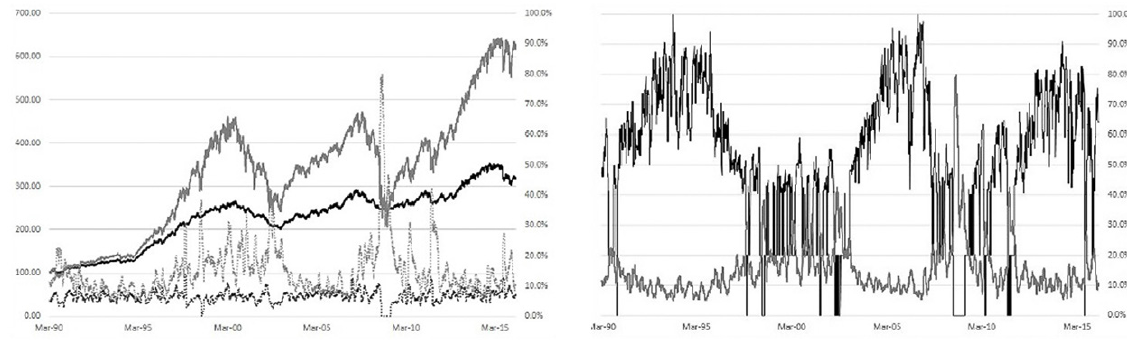
Figure 4. Comparative results for the DTVS VIX portfolio and the S&P 500 Note: The left side presents the path of DTVS VIX (solid black line) and of S&P 500 (solid gray line), and the DTVS VIX rolling standard deviation (dotted black line) and the S&P rolling standard deviation (dotted gray line). The right side presents how the equity exposure of the DTVS VIX (solid black line) changes with respect to the volatility of the S&P 500 (solid gray line).